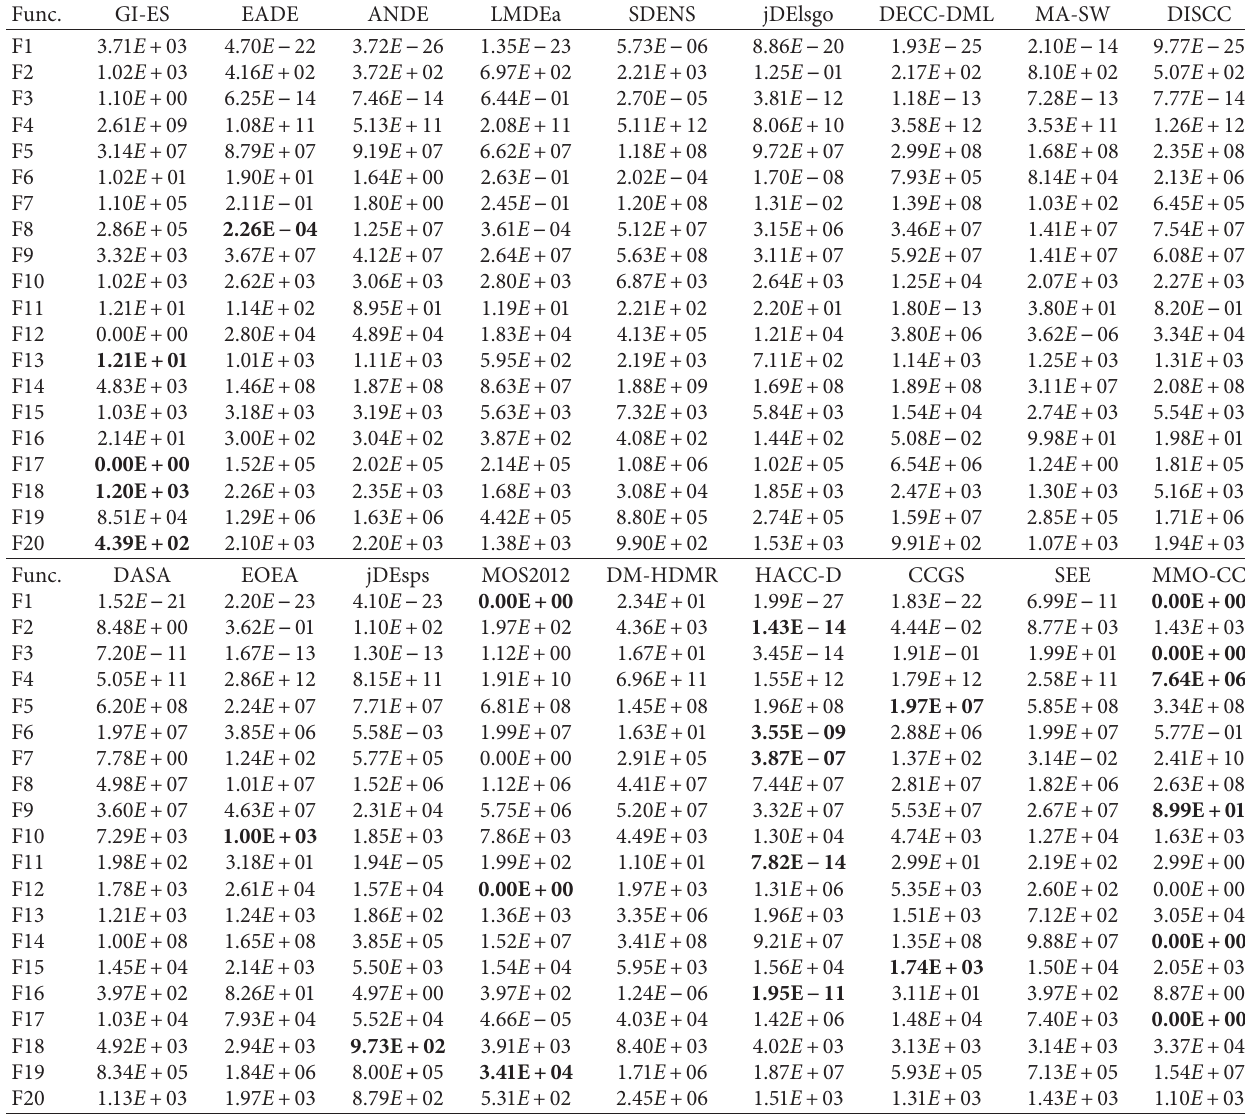
Table 6: Experimental comparisons between GI-ES and state-of-the-art algorithms using CEC2010.